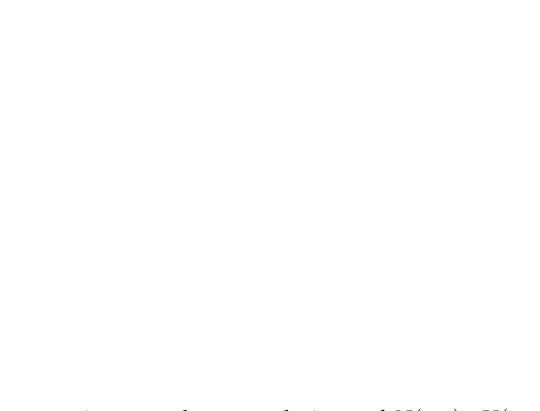
Figure 4. Three-dimensional plots of the approximate and exact solutions of U ( x , t ) , V ( x , t ) (Example 2) using the LADM.